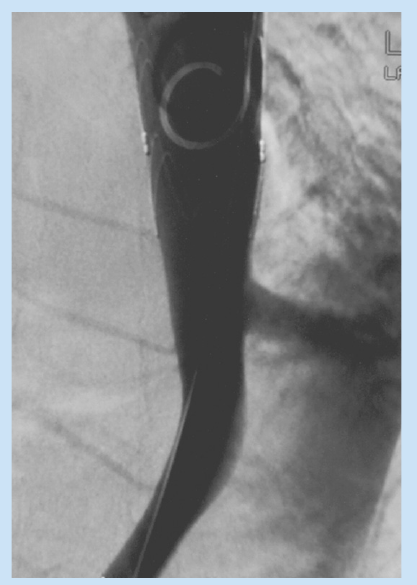
Fig. 2a. Stanford type B dissection in a 64-year- old male with the entry site in the descending aorta.